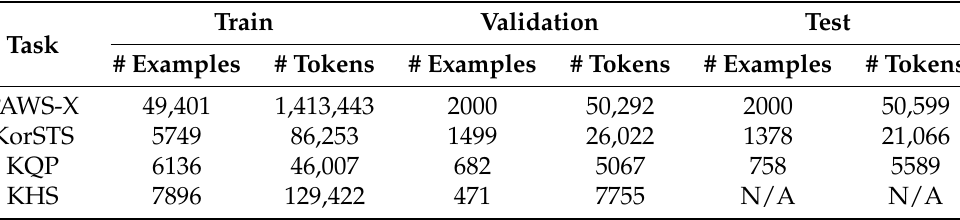
Table 1. Statistics of the datasets used in the downstream